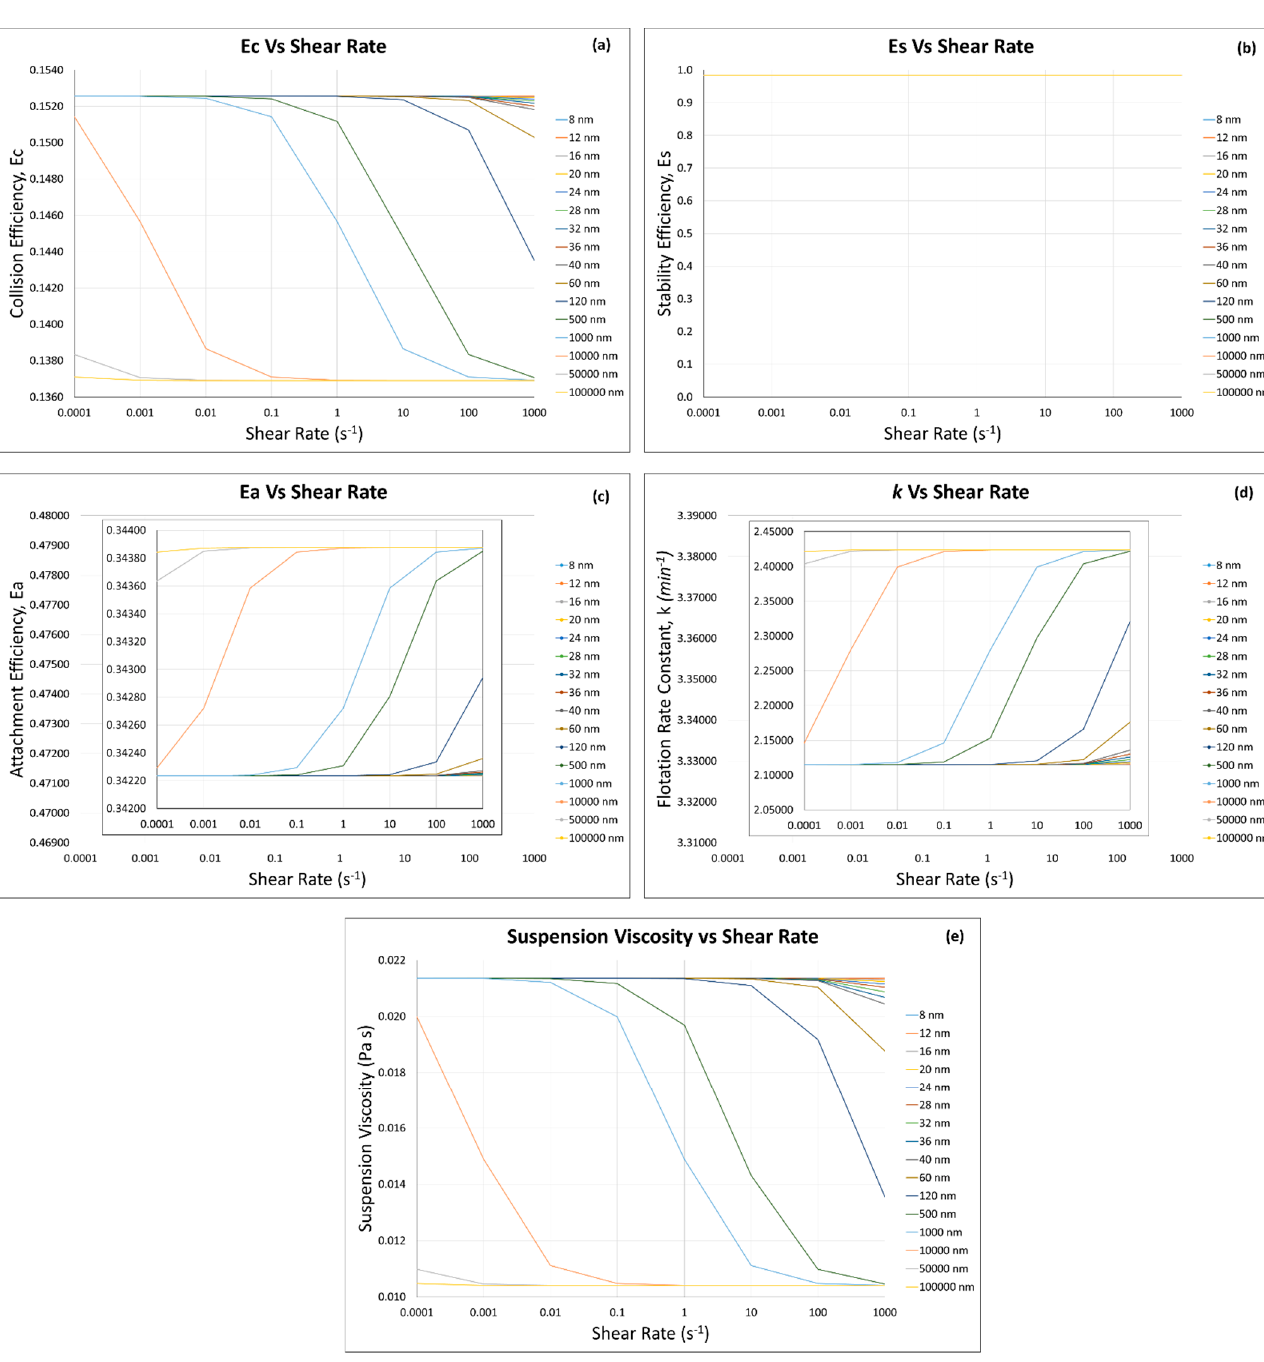
Figure 8. Flotation efficiencies: ( a ) collision, ( b ) stability, ( c ) attachment, and ( d ) rate constant by using the ( e ) respective suspension viscosity calculated by modified Krieger and Dougherty model at 𝜙 = 0.5. Note: the major y-axes of subfigures ( c , d ) are made for the purpose of comparison.